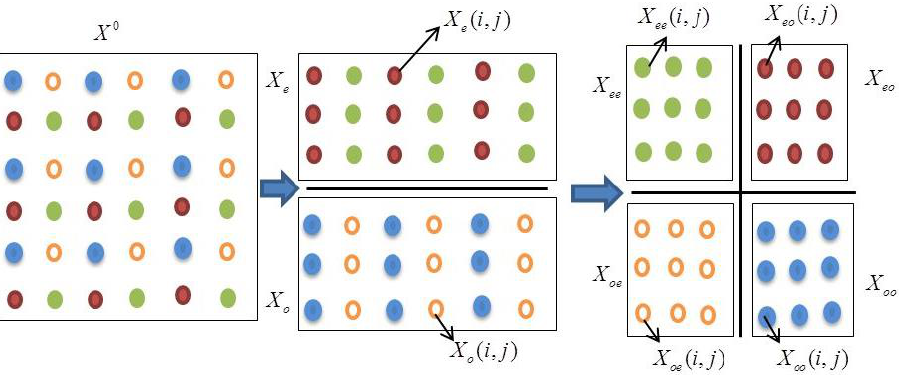
Figure 5. Input image and its decomposition image.